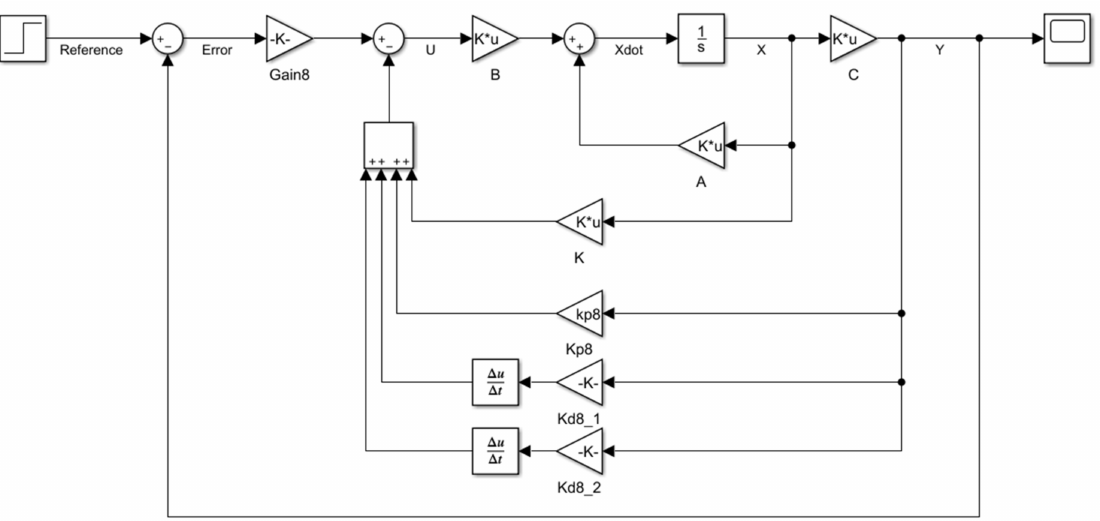
Figure 1. The structure of the hybrid proportional double derivative and linear quadratic regulator (PD2-LQR)